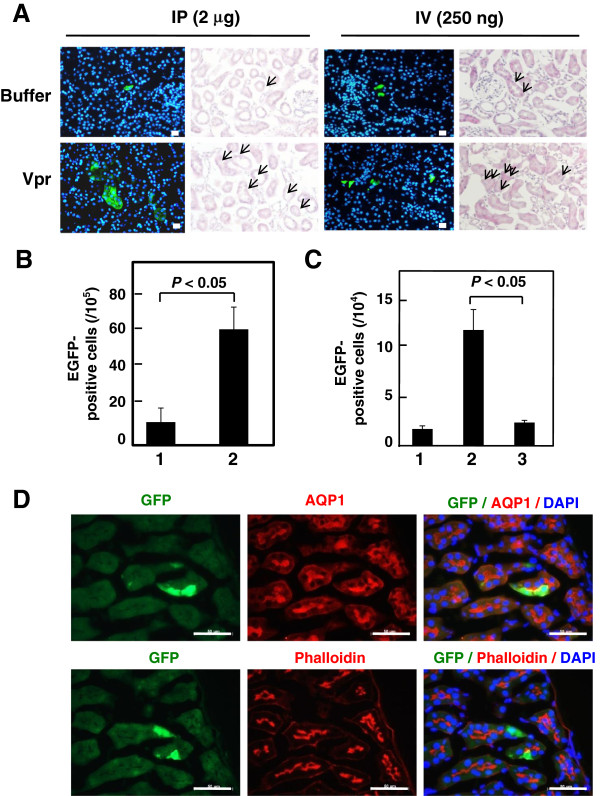
rVpr induces L1-RTP in proximal RTECs. A. Detection of rVpr-induced L1-RTP in kidneys. Immunohistochemical analysis using α-GFP was performed. hL1-Tg mice were administered once with 2 μg rVpr intraperitoneally (left four panels) or 250 ng rVpr intravenously (right panels). Upper panels, buffer control; lower panels, rVpr. Green, EGFP-positive cells; blue, Hoechst 33258 staining. Histology after H/E staining was also depicted. Bar, 20 μm (×200). Arrow, EGFP-positive cells. B. Induction of L1-RTP in kidney. Results after six times intravenous injections of 10 ng rVpr were shown. Column 1, buffer control; column 2, rVpr. For each sample, three different slices were prepared and the immunohistochemical analysis was done. Obtained numbers of EGFP-positive cells were then subjected to statistical analysis. P < 0.05. C. rVpr induced L1-RTP was blocked by 4′-Ed4T. Effects of 4′-Ed4T on the induction of L1-RTP by rVpr were examined using #4 hL1-Tg mice. Mice were intravenously injected with 250 ng rVpr six times. To examine the effects of 4′-Ed4T, the compound of 50 μmoles was intraperitoneally injected 2 h prior to injection of rVpr. The inhibitory effects of 4′-Ed4T were statistically significant (P < 0.05). Column 1, buffer; column 2, 250 ng rVpr; column 3, 250 ng rVpr + 4′-Ed4T. D. rVpr induced L1-RTP in proximal RTECs. Double staining with α-AQP1 or α-phalloidin was performed. Bar, 50 μm (×400). hL1-Tg mice were intravenously injected with 10 ng rVpr six times. In this experiment, no EGFP-positive cells were detected in the control kidney of mouse that was injected with buffer.